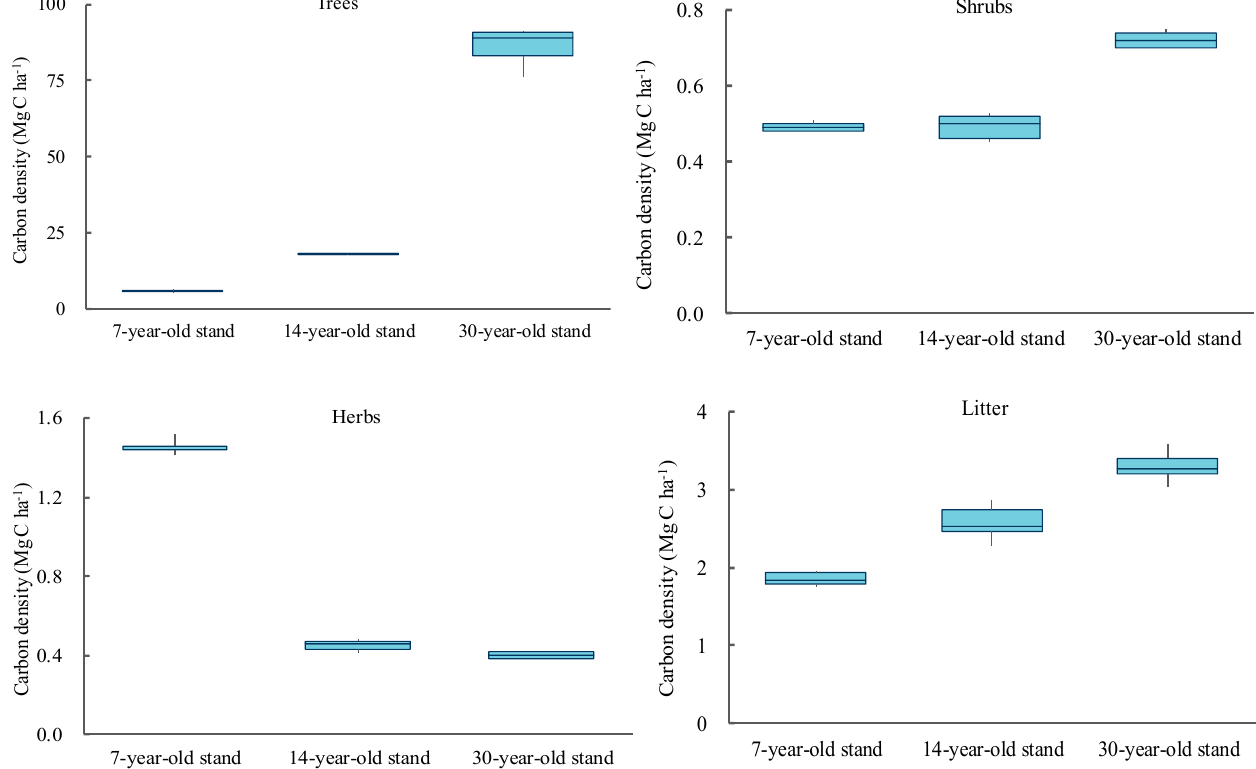
Figure 4. The variation in carbon density in different plant types and litter across a chronosequence of Masson pine plantations.